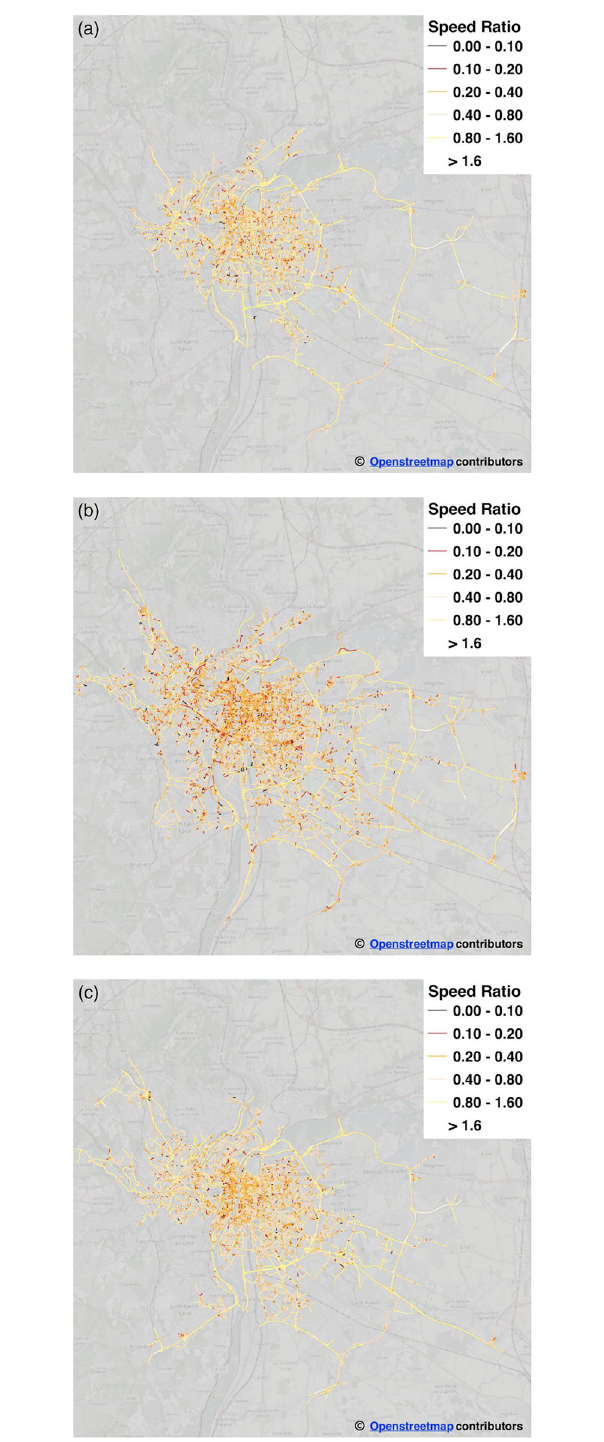
Fig 4. The dynamic taxi graph: Median-speed-to-max-speed ratio at different hours of the day. Edge color (from black/red to yellow) indicates higher speed-ratio, i.e., reduced congestion) (a) 05:00 (b) 08:00 (c) 20:00.